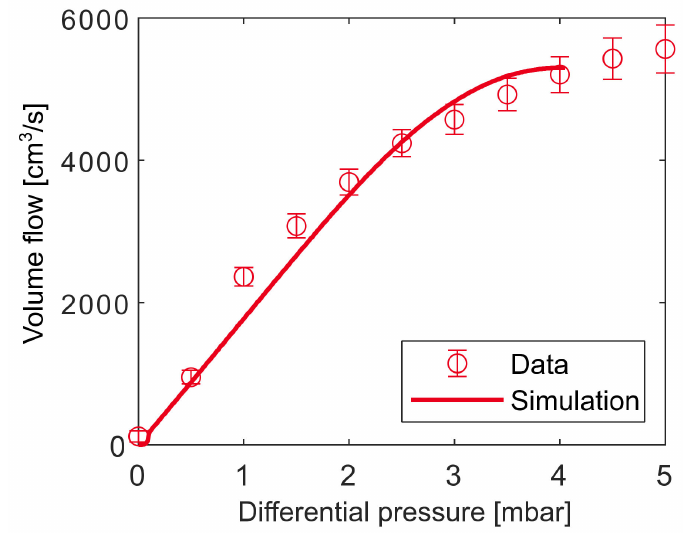
Figure 2. Schema of the simulation. Thermal data are shown in red and fluid data in blue. The evaporator has the temperature T c and is connected to the environment via the thermal resistance R Iso representing the insulation. The heat flux The cooling power is measured on the basis of the heat flux the segment by a check valve. Here, the ECM is compressed along a sinusoidal stress profile. The ECM is connected to the environment via the thermal resistance R K and the heat flux is connected to the fluid via R th . The heat flux at this resistance is segment into the condenser at temperature T h . From the condenser, the heat flux into the environment. The fluid flows back into the evaporator through a throttle. The temperature span of the AEH is ∆ T = T h − T c .